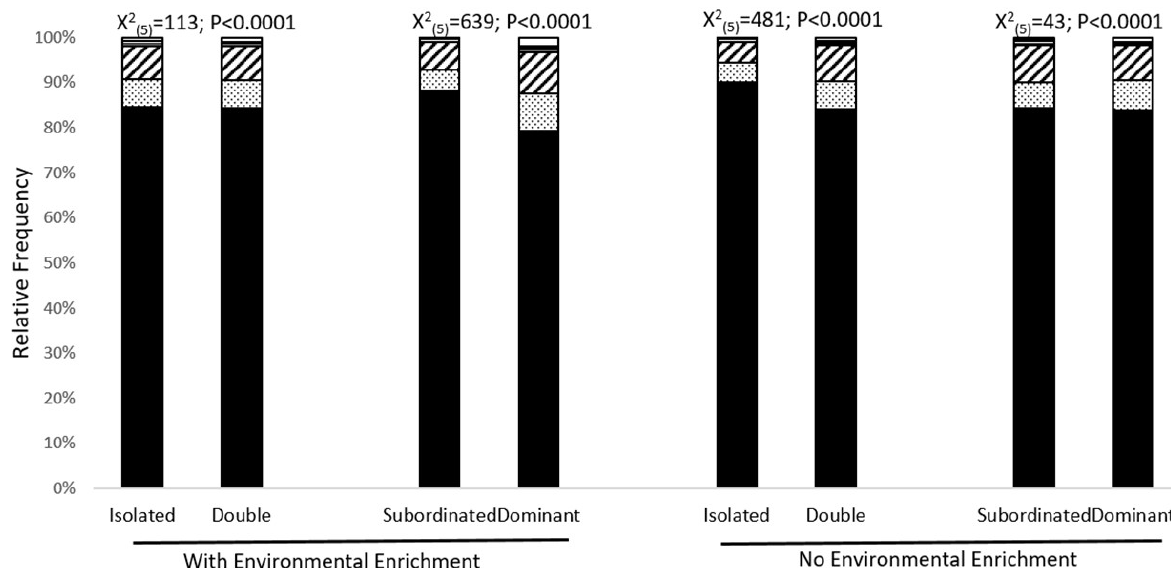
Figure 3. Relative frequency of motor patterns related to the Social Interaction category. Absolute frequencies were compared between isolated and double animals and between subordinate and dominant animals using the chi-square test, with significantly higher values (P < 0.05) accompanied by an asterisk